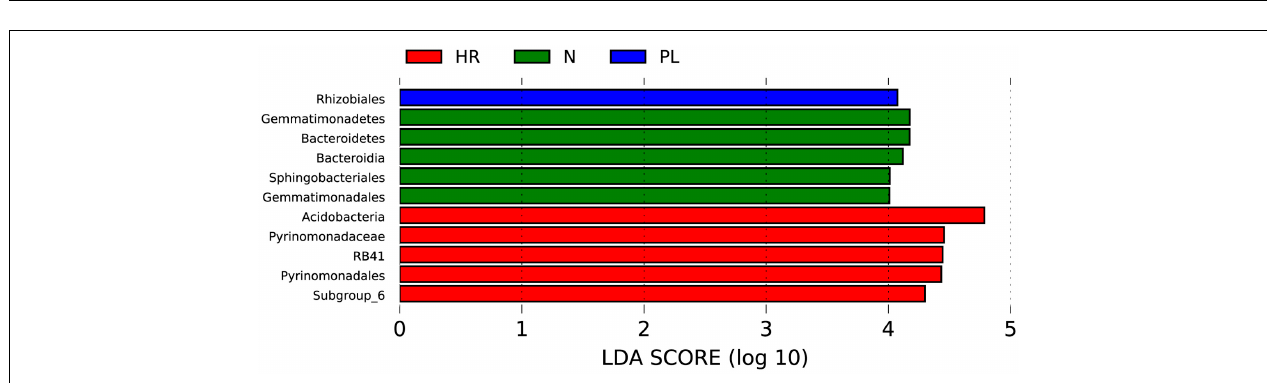
FIGURE 6 | Relationships between microbial community and soil properties (A) Redundancy analysis (RDA) of soil properties and bacterial abundance in the C. yanhusuo rhizosphere. The angle and length of the arrows indicate the direction and strength of the relationships of soil factors vis-à-vis the microbial populations. CEC, cation exchange capacity, SOM, soil organic matter, TN, total nitrogen, TP, total phosphorus, TK, total K. The CEC ( r 2 = 0.798, p = 0.002), SOM ( r 2 = 0.382, p = 0.036) and TP ( r 2 = 0.308, p = 0.047) were significant factors that influenced the microbial community structure of the C. yanhusuo rhizosphere. (B) Genus influenced by different soil properties in the rhizosphere of C. yanhusuo (* p < 0.05, ** p < 0.01, *** p < 0.001; Spearman correlations). N, soil from the C. yanhusuo field without rotation; HR, soil from the C. yanhusuo field that had been flooded in July 2020; PL, soil from the field under peanut– C. yanhusuo rotation.